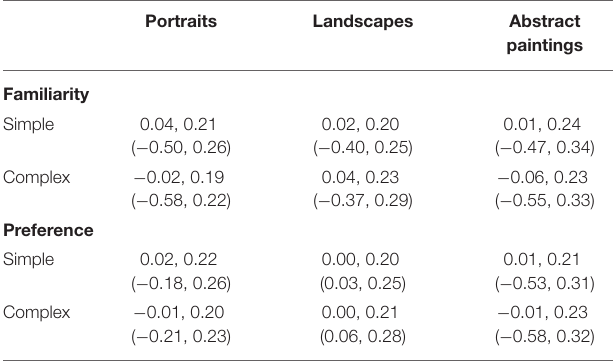
TABLE 3 | The mean familiarity and preference Z-scores and SD (raw scores, SD) for the selected images of paintings in the six